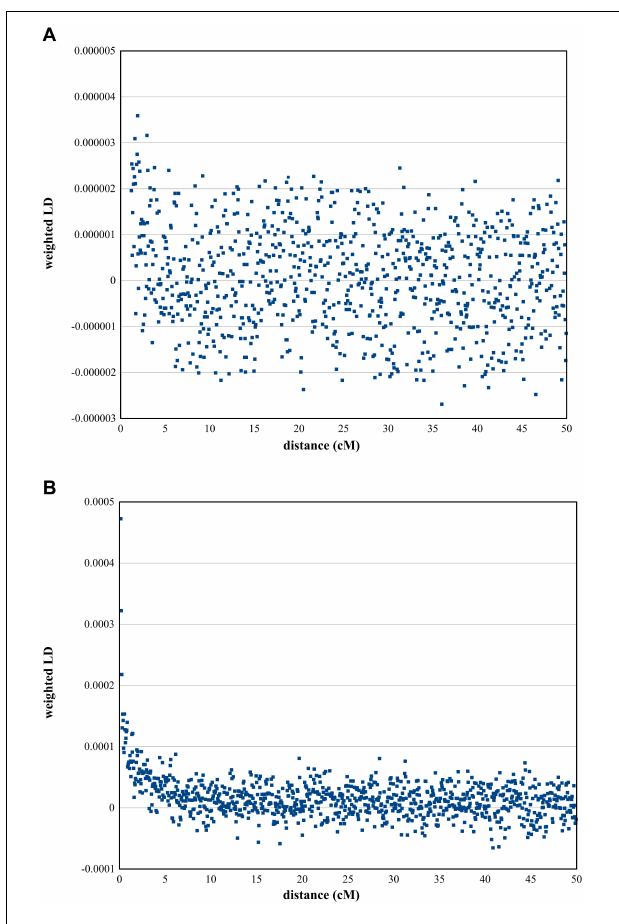
FIGURE 5 | ALDER analysis results. Weighted LD curves calculated by the ALDER algorithm. (A) Weighted LD curve of Hungarians representing OEC and the two reference populations Turks and Portuguese. (B) Result of ALDER analysis using Roma as target group and two reference populations, Turks and